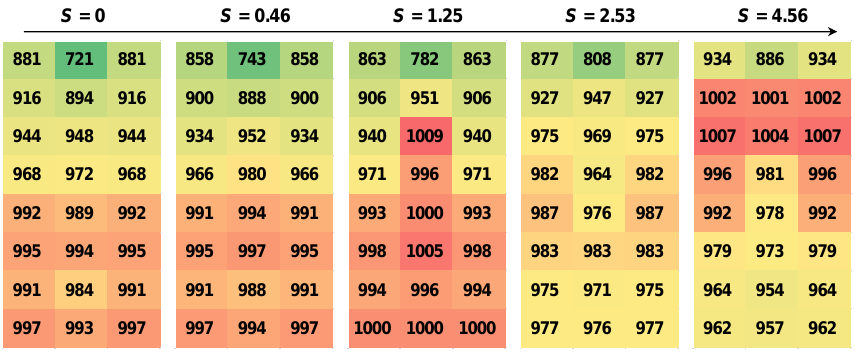
= 150 kPa and φ = 0.8.